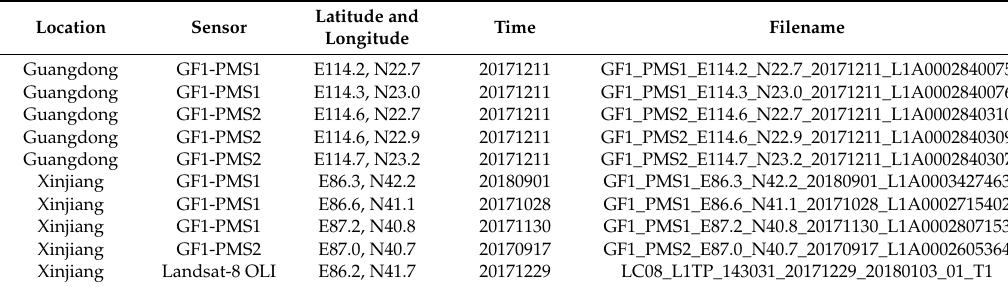
Table 4. The information of used